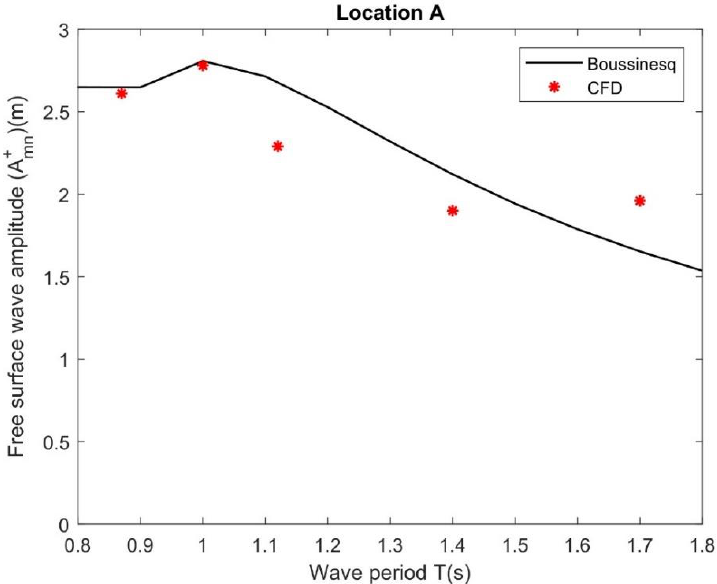
Figure 13. Comparison of Boussinesq, second-order super-harmonic wave amplitude A + mn in Equation (29) and CFD models of free surface elevation for location A.